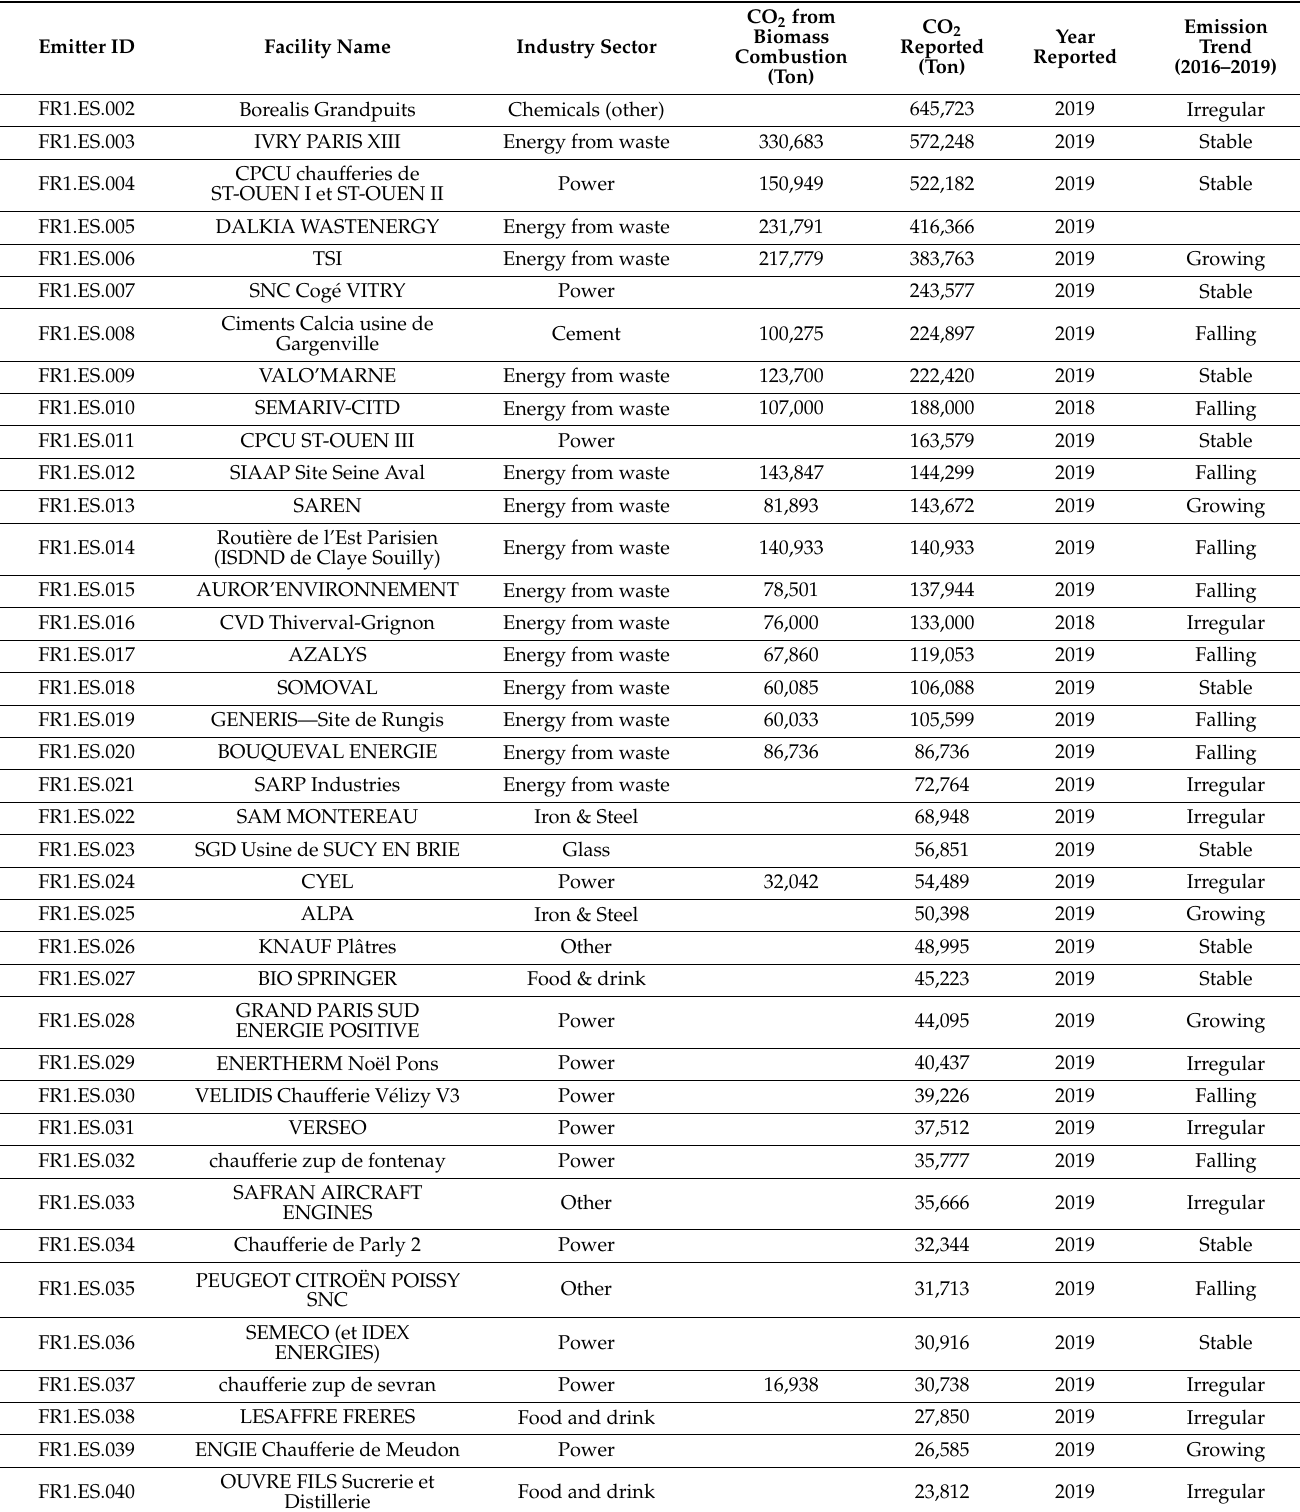
Table A1. Quantity reported and the emission trend between 2016 and